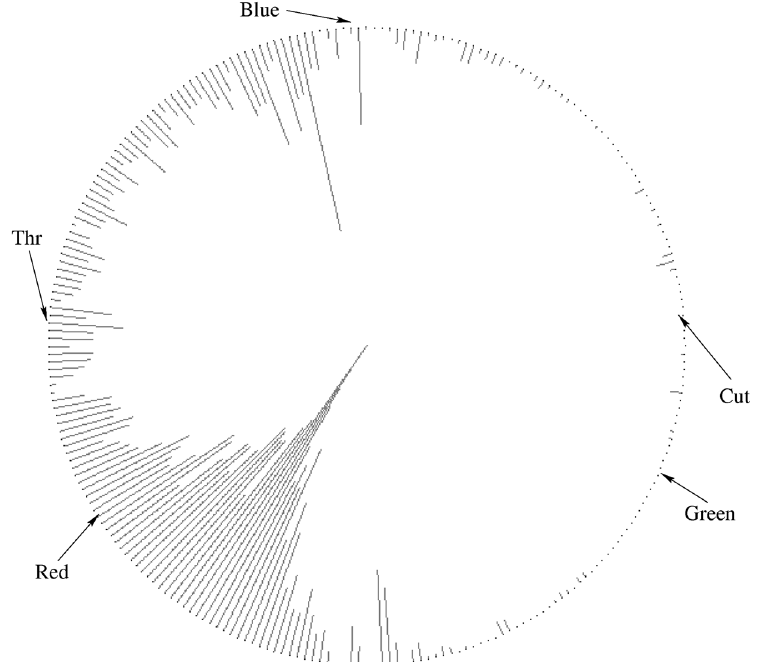
Fig. 4. PCH histogram for control nuclei. This circular histogram is treated as a linear histogram by cutting the circle open at the ‘cut’ position, i.e., adding an offset so that the position of the cut gets the value 0.